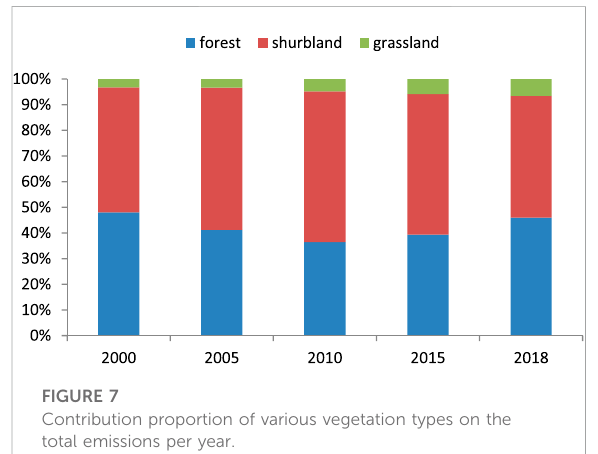
FIGURE 7 Contribution proportion of various vegetation types on the total emissions per year.